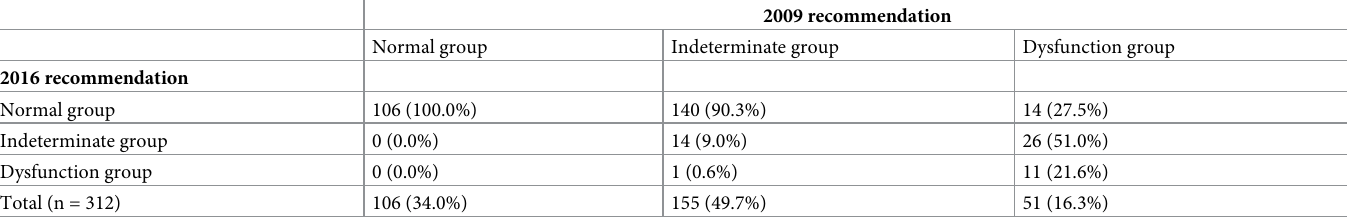
Table 3. Concordance in diastolic dysfunction prevalence according to the 2009 ASE/EAE recommendations and the 2016 ASE/EACVI